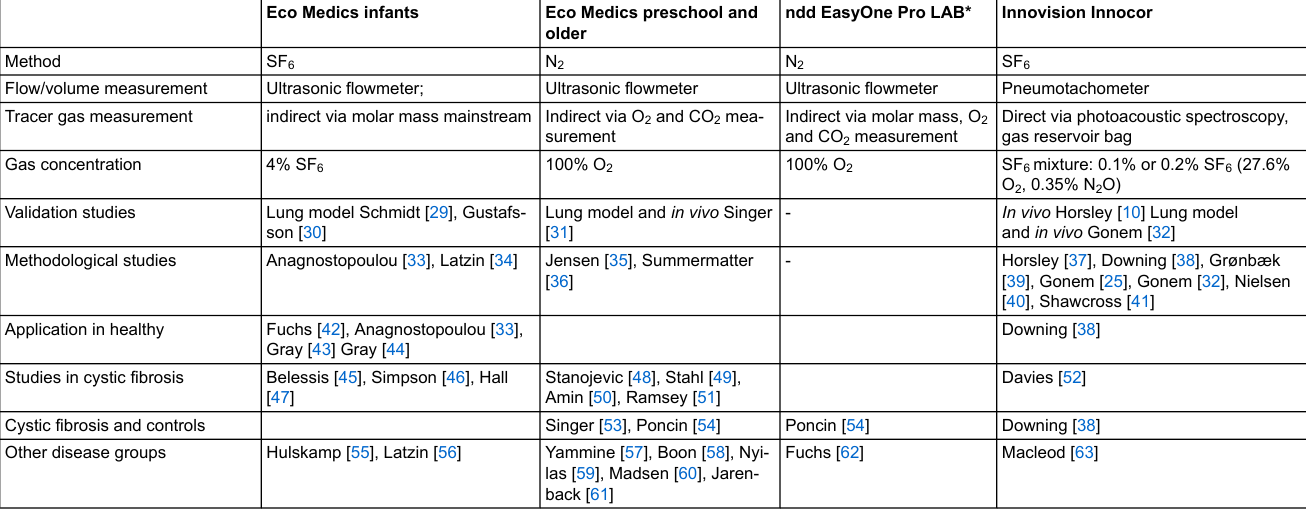
Table 1: Currently available multiple breath washout